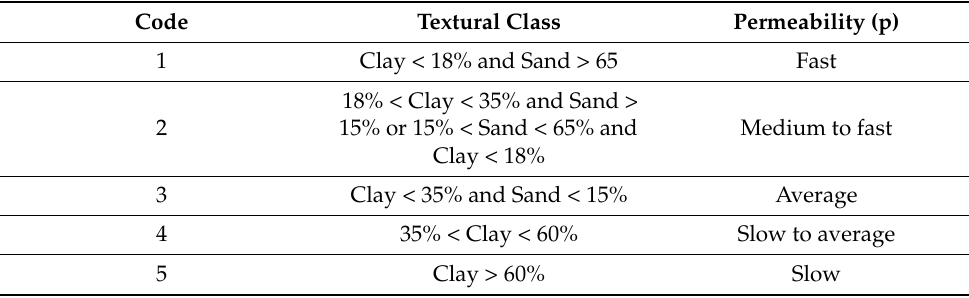
Figure 2. USDA textural diagram. Table 2. Meaning of permeability (P)